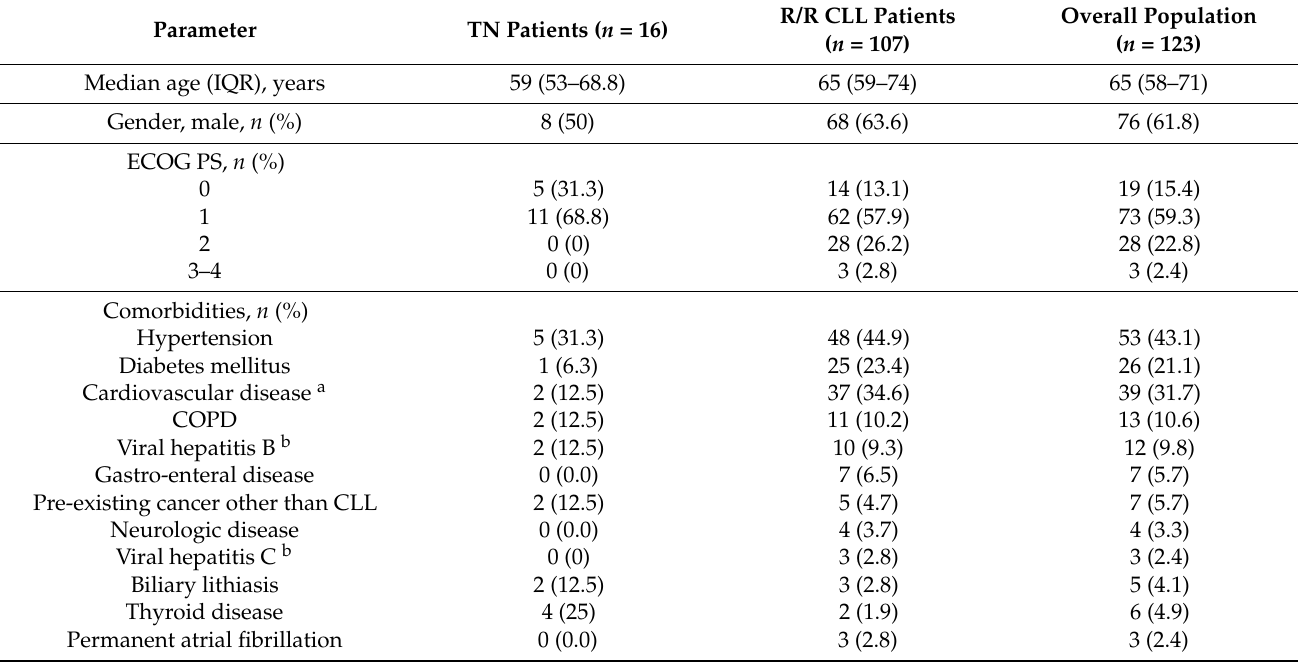
Table 1. Baseline characteristics of patients at start of ibrutinib treatment in the overall population and in the treatment-naïve and R/R CLL